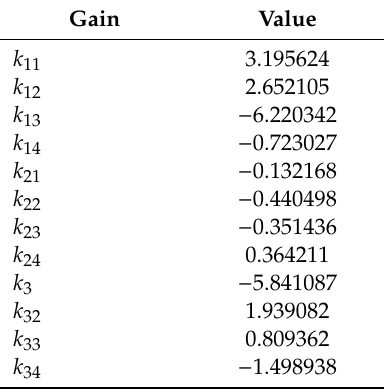
Table A6. Gains of the observer for ω r <